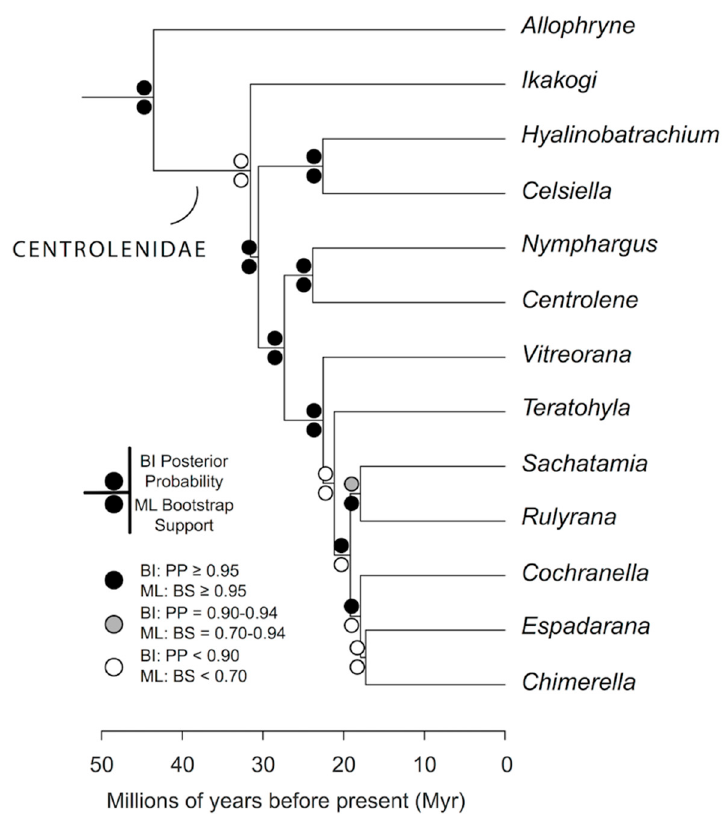
Figure 19. Evolutionary relationships among glassfrog genera (family: Centrolenidae) under maximum likelihood and Bayesian criteria.